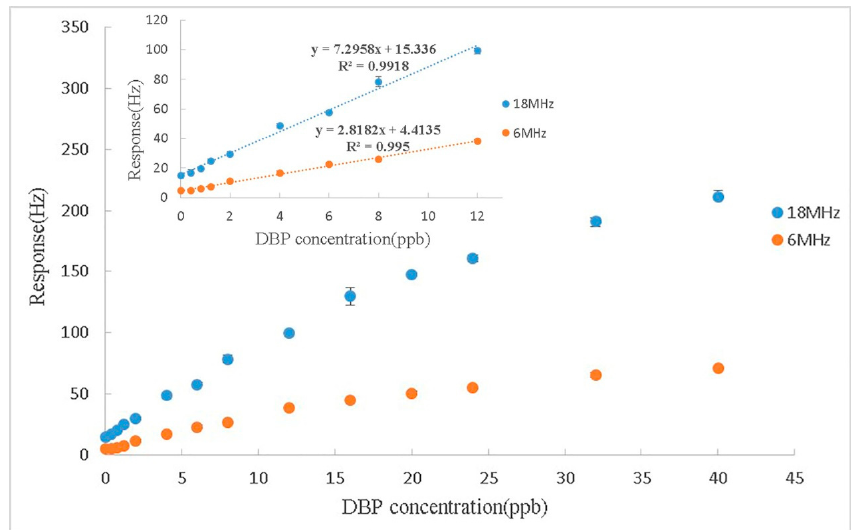
Figure 8. Calibration curve of the nano-Ni(OH) 2 -coated QCM sensor to different concentrations of DBP vapor. The red line is the response when the quartz oscillator works at the fundamental frequency, while the blue one works at 3rd harmonic. The inset indicates the calibration curve of the linear range.